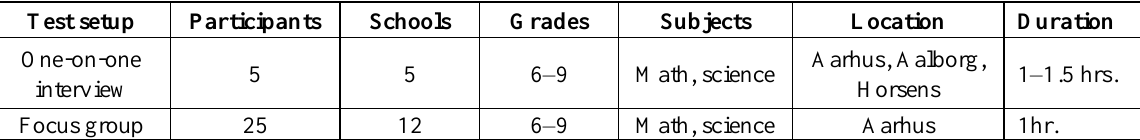
Table 1. Participants’